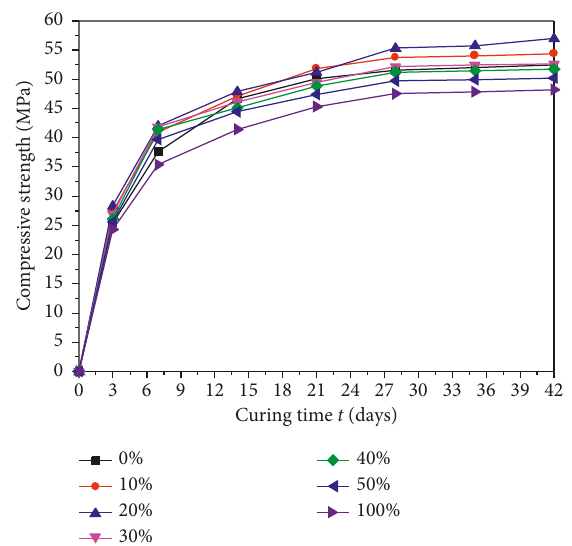
Figure 4: Relation between compressive strength and curing